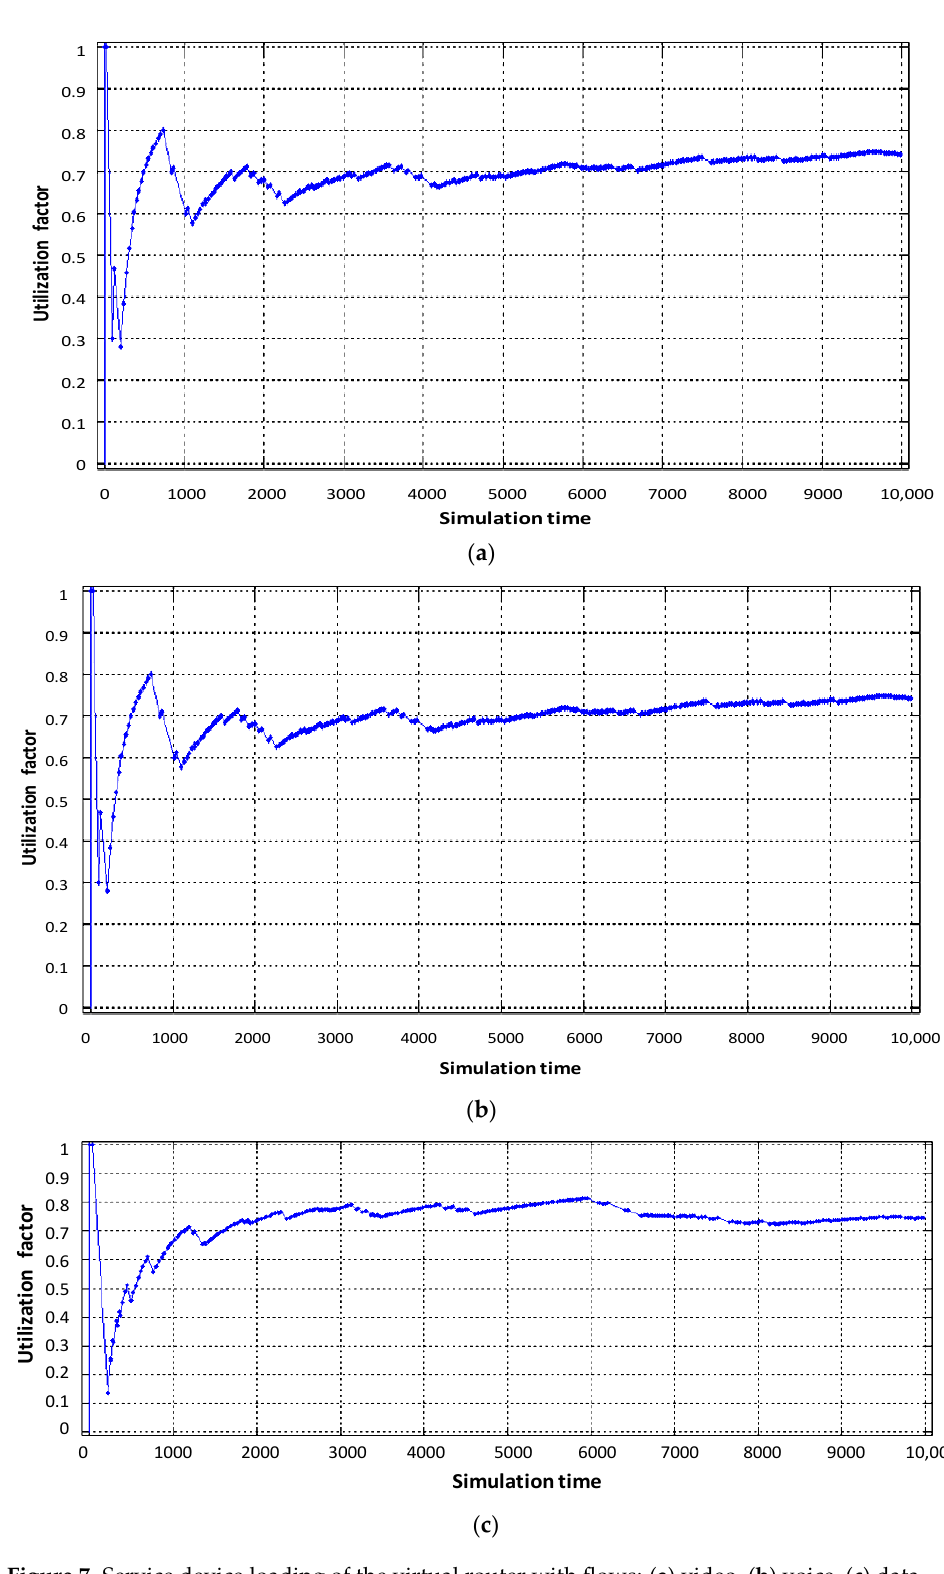
Figure 8. Service device loading of the physical router with Triple Play flows. ( a )